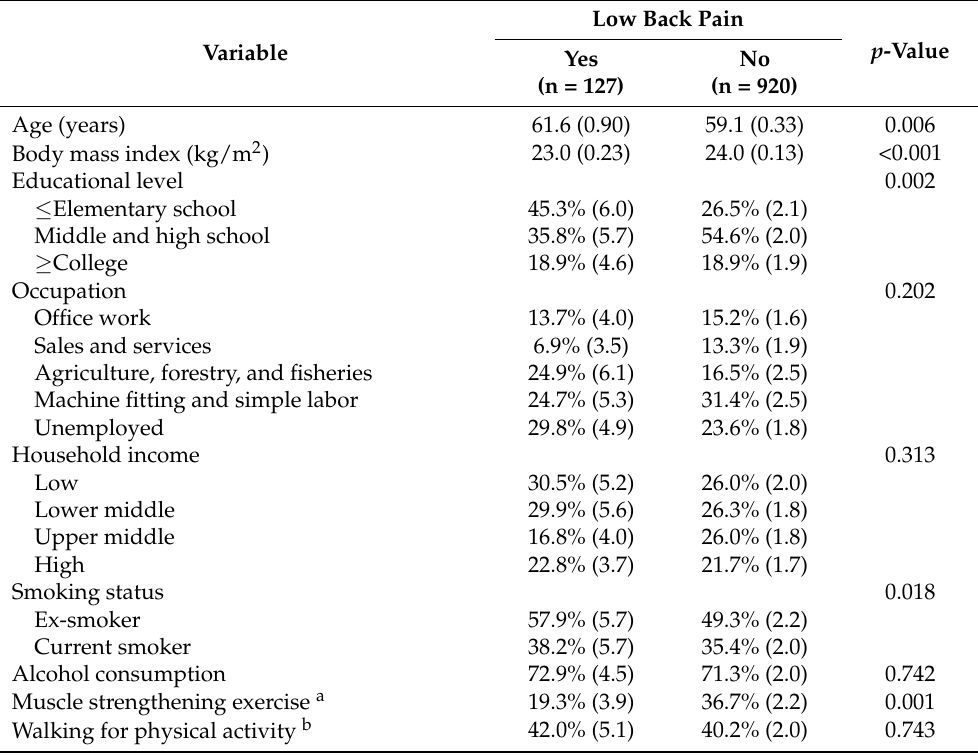
Table 2. Factors associated with low back pain in